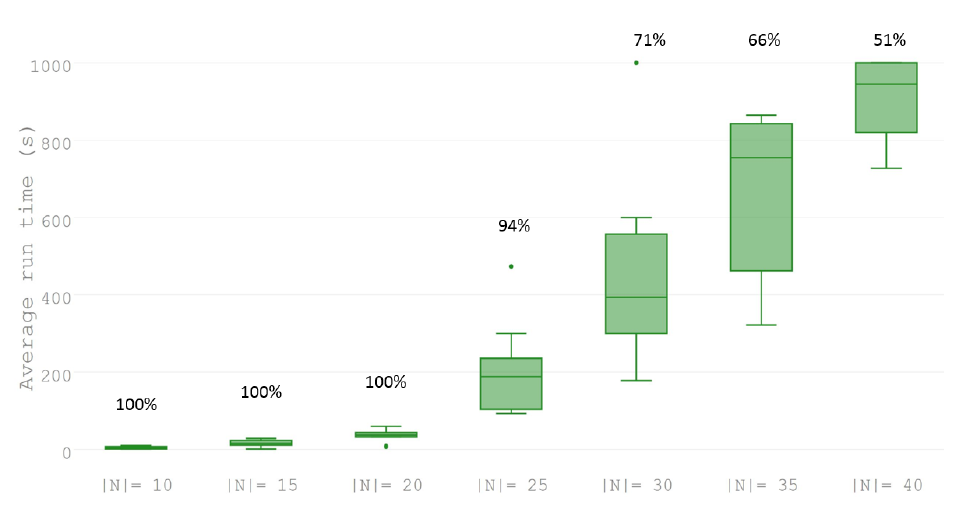
Figure 9. Box plot highlighting performance of the model proposed as instance size increases.